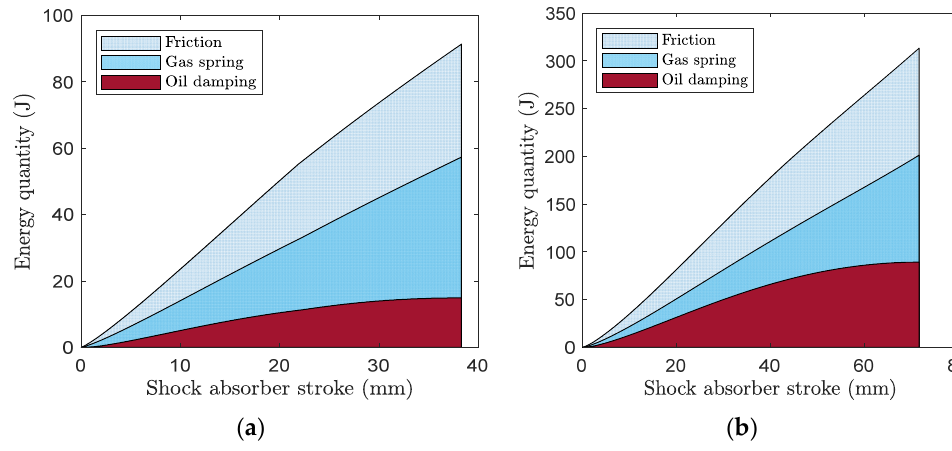
Figure 8. Energy absorption quantity trend of elemental forces: ( a ) LC-1; ( b ) LC-2.